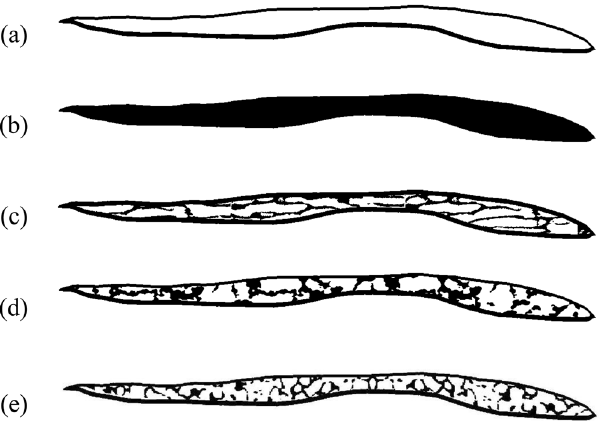
Figure 2. Five bone models. ( a ) Empty model, ( b ) uniform model, ( c ) parallel equine model (sample A), ( d ) swine model (sample B) and ( e ) human model (sample C). Approximate length of the models is 65 mm.